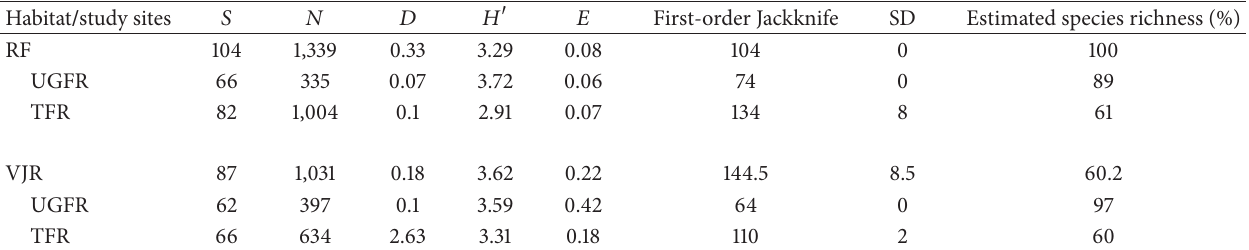
Table 1: Diversity and species richness of understorey birds inhabiting regenerated forest (RF) and virgin jungle reserve (VJR) at two study sites, Ulu Gombak Forest Reserve (UGFR) and Triang Forest Reserve (TFR). Habitat / study sites 𝑆